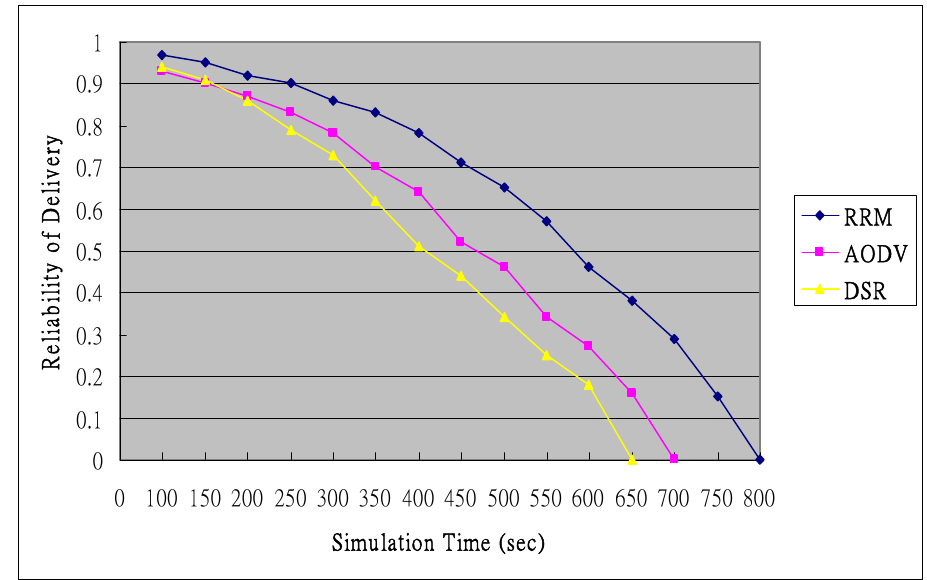
Figure 16. Average reliability of